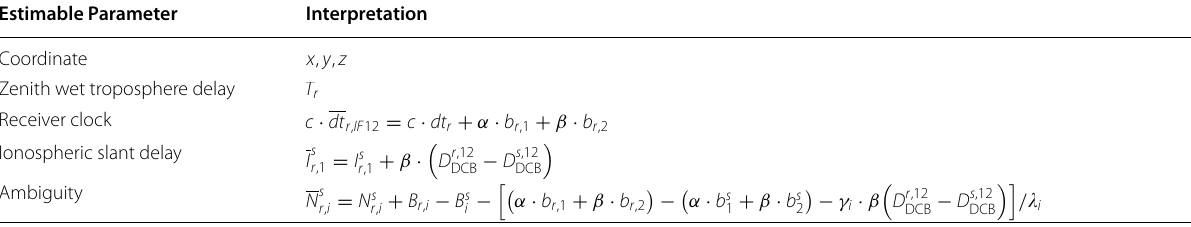
Table 1 Estimable parameters of the reparameterized UDUC PPP equation for